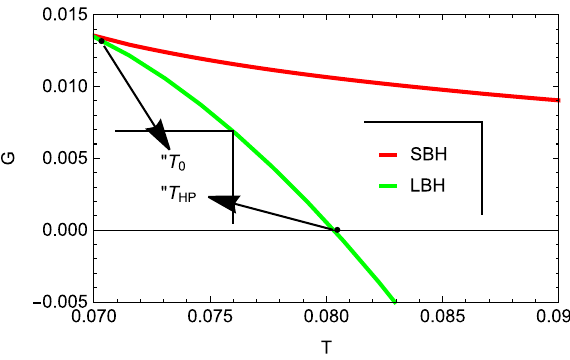
Fig. 9 Plot of the event horizon radius r + in terms of the temperature T